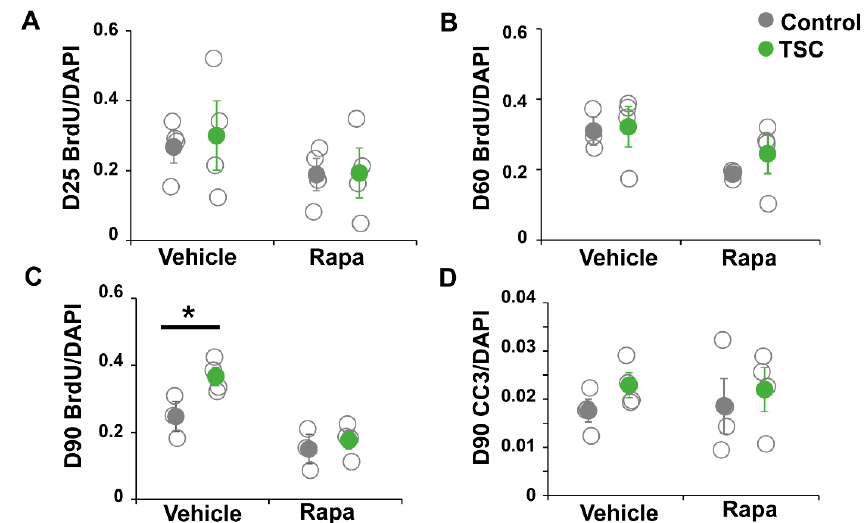
Figure 2. iPSC-derived TSC astrocytes show increased proliferation. A bromodeoxyuridine (BrdU) proliferation assay was performed on day-25 progenitor cells ( A ), day-60 astrocytes ( B ) and day-90 astrocytes ( C ). At day 25 and day 60, no differences in proliferation rate were observed. At day 90, TSC astrocytes showed a significantly increased proliferation compared to control astrocytes, which was rescued by rapamycin treatment. ( D ) No changes were observed in apoptosis rates in TSC cells, measured by cleaved caspase 3 (CC3) staining. ( A – D ) Data points represent proliferation ( A – C ) or apoptosis ( D ) rates of each iPSC line (average of two experiments) with solid data the points representing mean per condition ± SEM. * = p < 0.05 Statistical test: independent samples t -test.